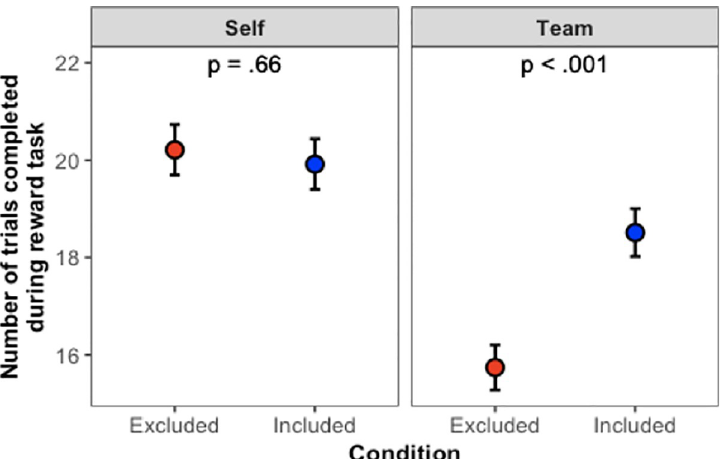
Fig 3. Main results from Study 1. Error bars show ± 1 SE.